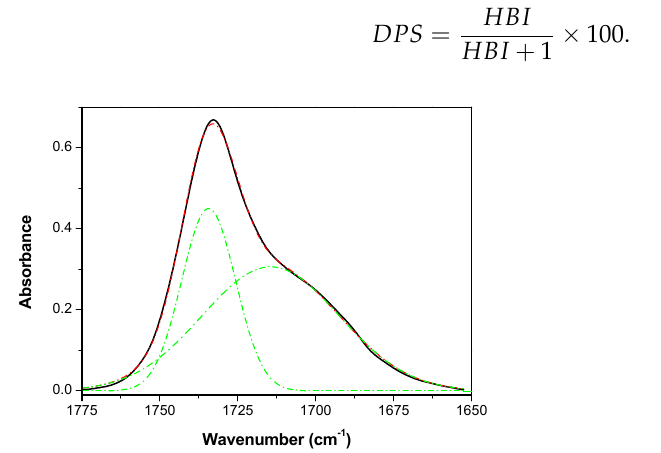
Figure 6. Example of Gaussian deconvolution to obtain the HBI as the ratio of absorption bands A 1703 /A 1732 (TPU with 2 wt.% MWCNT).